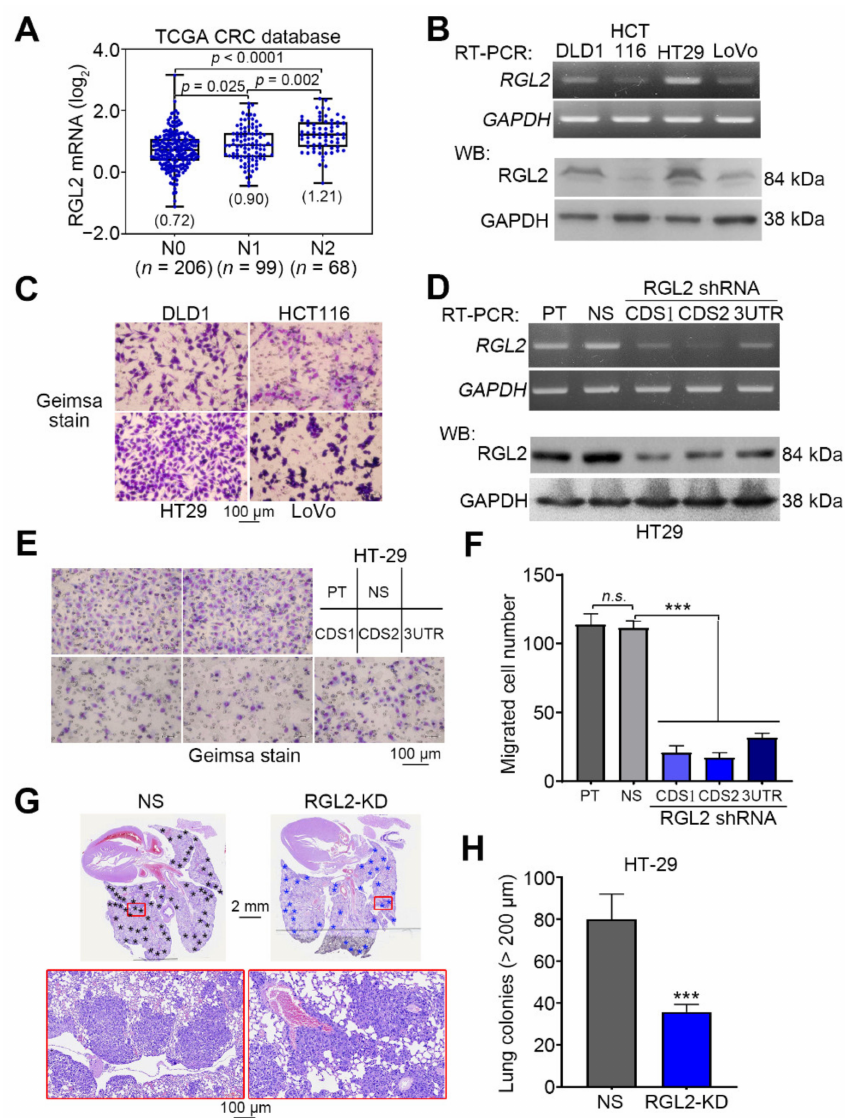
Figure 3. RGL2 expression is causally associated with the metastatic potential of CRC cells. ( A ) Box- plot for the transcriptional profiling of RGL2 in the TCGA CRC samples from patients with different pathologic N stages. ( B ) Reverse transcription-PCR (RT-PCR) and Western blot analyses of the mRNA and protein levels, respectively, of RGL2 and glyceraldehyde-3-phosphate dehydrogenase (GAPDH) in the selected CRC cell lines. ( C ) Geimsa staining for the migrated cells in the transwell cultivation of the selected CRC cell lines. ( D ) RT-PCR and Western blot analyses of the mRNA and protein levels, respectively, of RGL2 and GAPDH in the parental (PT), nonsilencing control (NS) and RGL2-silenced HT-29 cell variants. In ( B , D ) GAPDH was used as the internal control for RT-PCR and Western blot experiments. Geimsa staining ( E ) and histogram ( F ) for the migrated cells of the HT-29 cell variant shown in ( D ). Hematoxylin and eosin (H&E) staining ( G ) and histogram ( H ) of the tumor colonies (black and blue star symbols) counted from the lungs of mice transplanted with NS and RGL2-knockdown (RGL2-KD) HT-29 cells. In F and H, the “n.s.” and “***” represent not significant and p < 0.001, respectively. The full Western blot images of B and D are shown in Figure